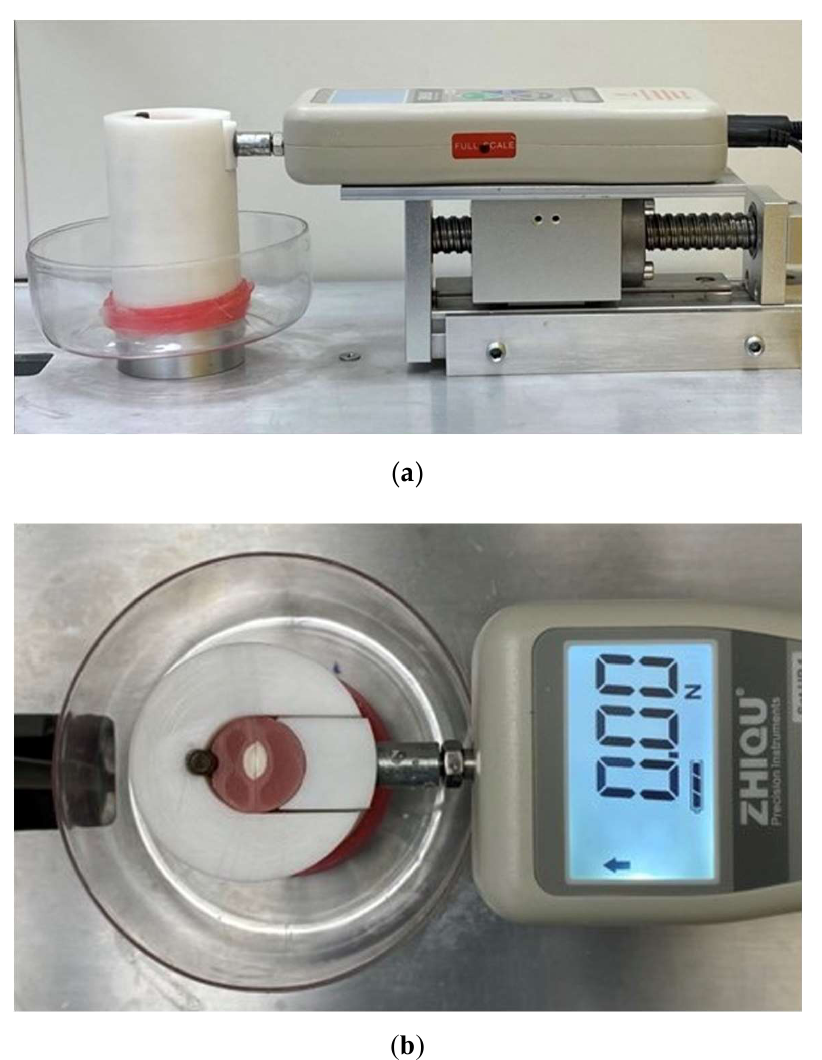
Figure 4. Lateral intracanal force measuring system. Display of the system setup ( a ) and force reading 0 N ( b ).